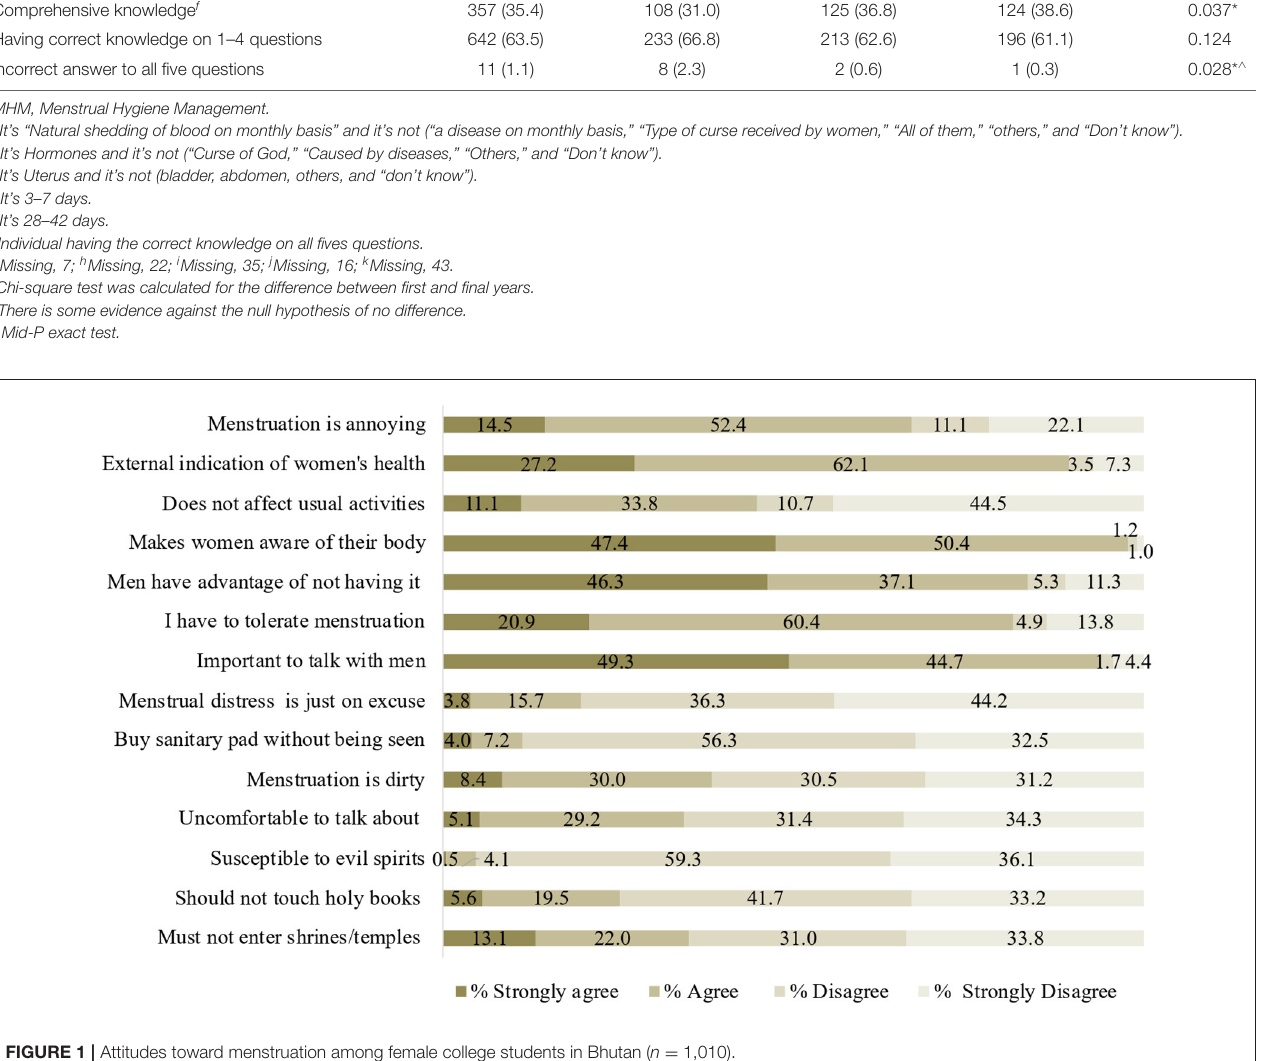
FIGURE 1 | Attitudes toward menstruation among female college students in Bhutan ( n = 1,010).